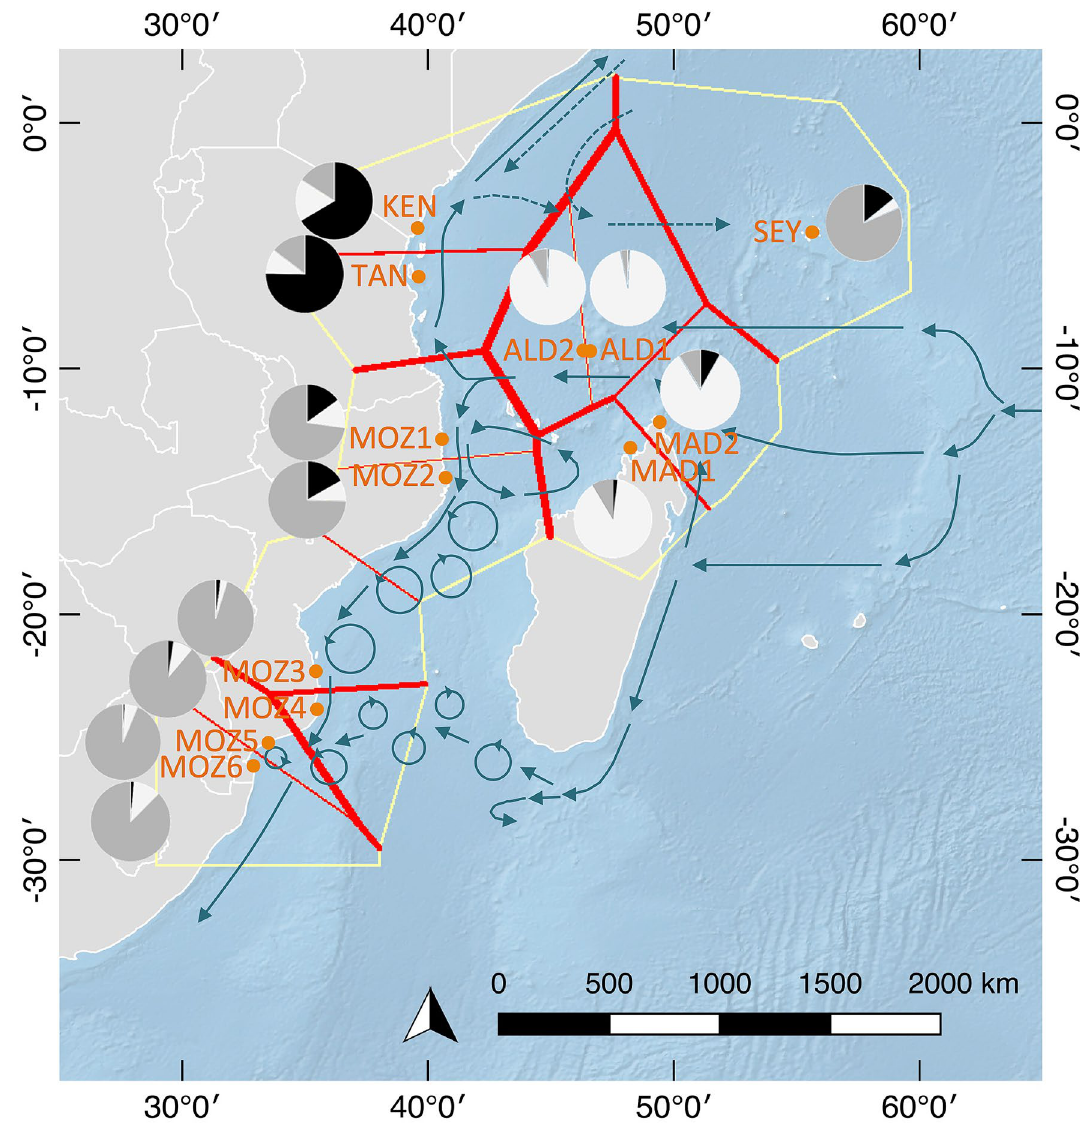
Figure 4. Genetic discontinuities (red lines) as revealed from the Barrier analysis (yellow polygons) and relative proportions of 3 genetic clusters (K = 3) for 13 Rhizophora mucronata populations in the Western Indian Ocean. The thickness of the red lines indicates the strength of genetic discontinuity between neighbouring populations. Population codes are denoted in Table 1. The background map was created with the QGIS 3.10.10 software (www.qgis.org), using detailed (1:10 m) ocean bottom relief, land and island polygons, as well as country administrative boundaries provided by Natural Earth (www.natur alear thdat